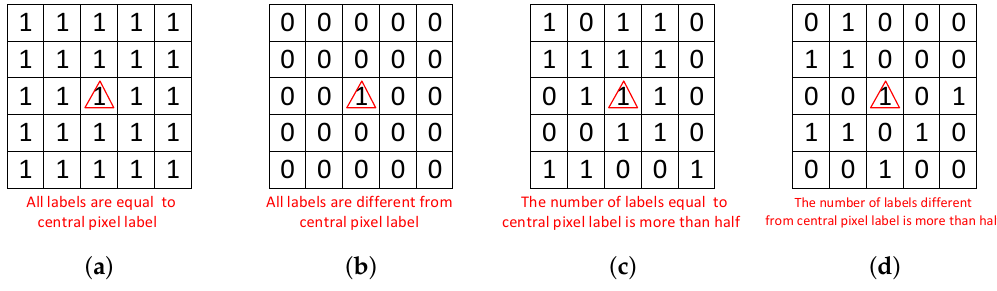
Figure 3. Different label neighbor information and sample selection according to the threshold. ( a ) All the labels are the same as the central pixel label. ( b ) All the labels are different from the central pixel label. ( c ) More than half of the labels are the same as the central pixel. ( d ) More than half of the labels are different from the central